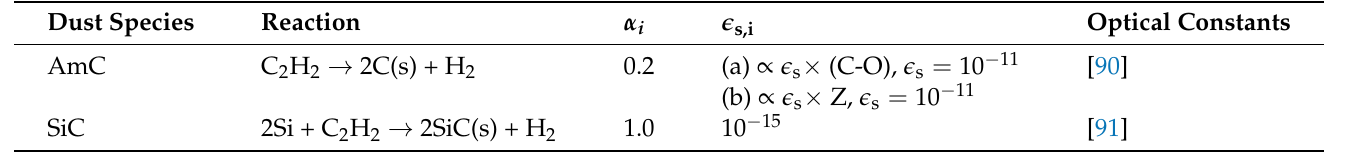
Table 1. Reactions and input parameters selected for the calculation of dust condensation. Dust